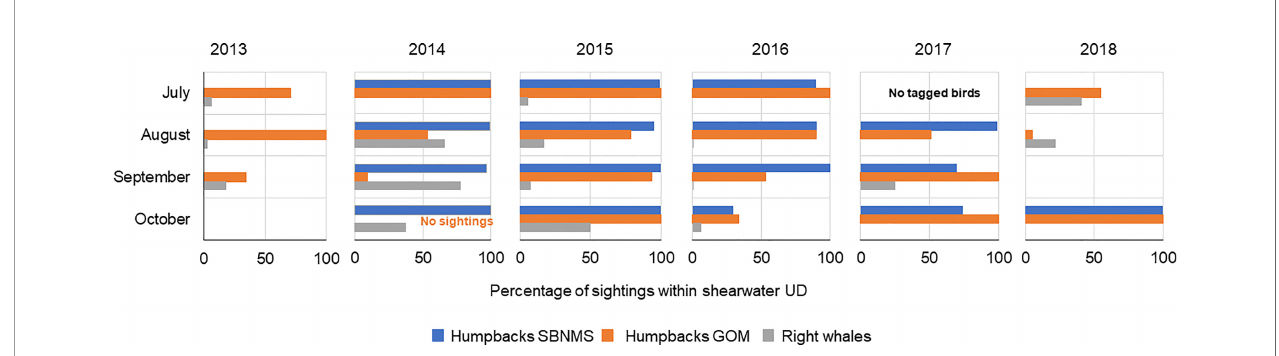
FIGURE 4 | Summary of monthly overlap across the study period showing the percentage of whale sightings overlapping with the respective shearwater utilization distribution (UD) in each month. Blue – humpback whale sightings in SBNMS, orange – humpback whale sightings in GOM, gray – North Atlantic right whale sightings. No birds were tagged in July 2017. The GOM-wide humpback whale survey did not extend into October in 2014 and was limited in that month in all